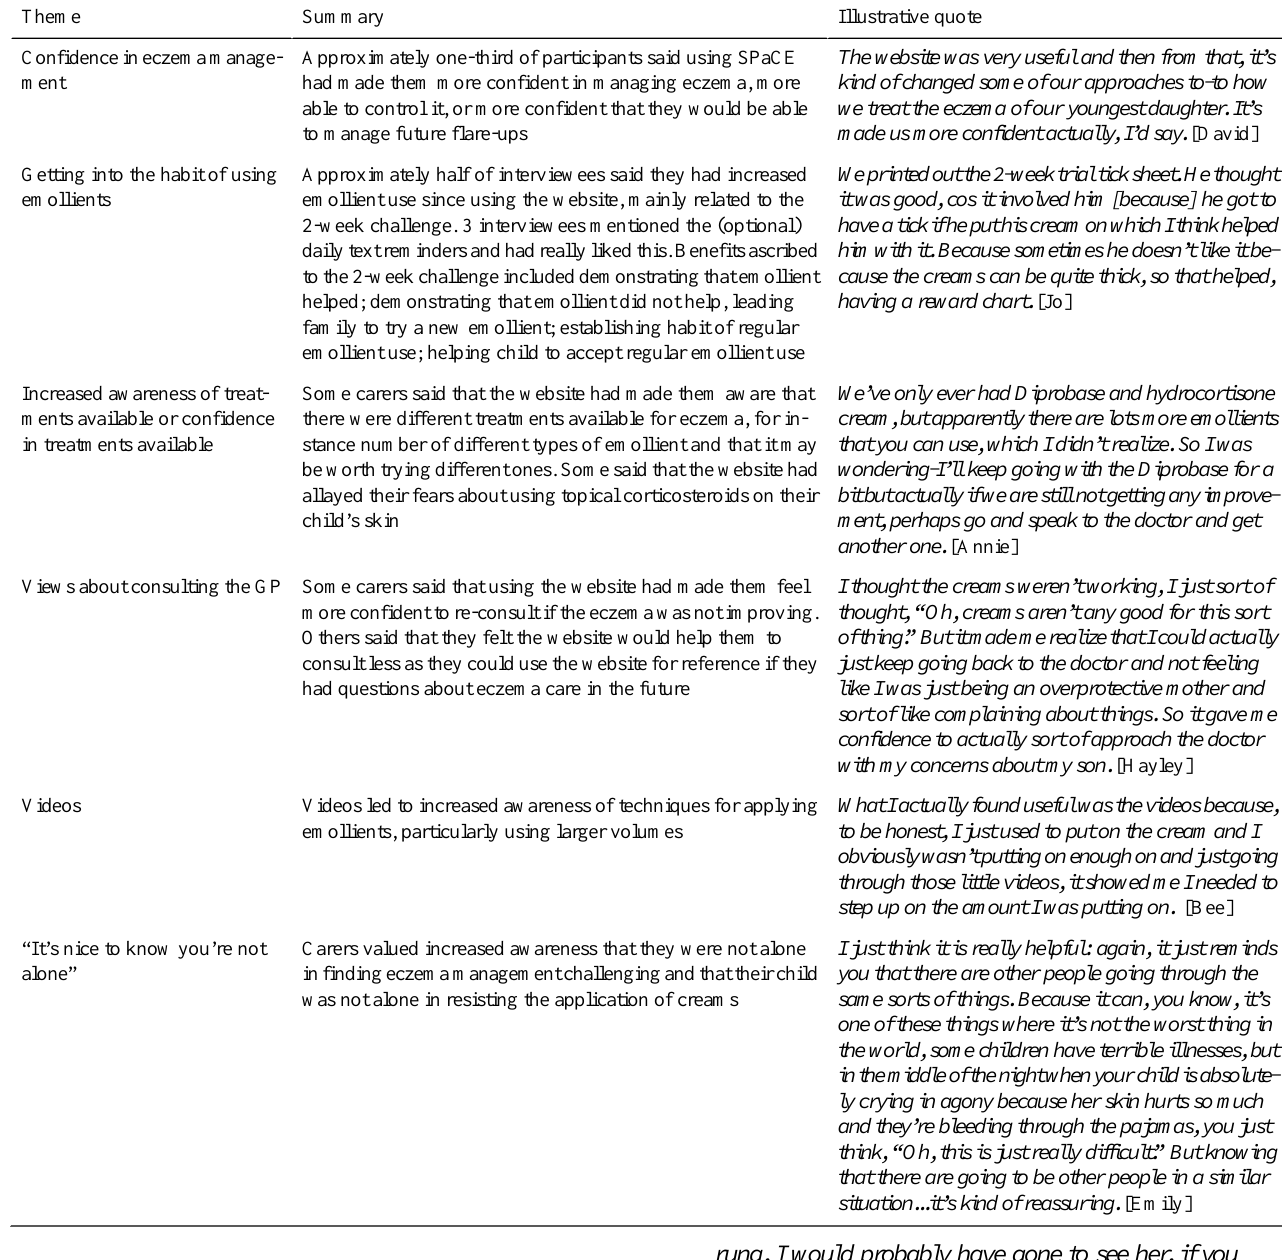
Table 5. Qualitative findings from participant interviews about experiences of using SPaCE website.